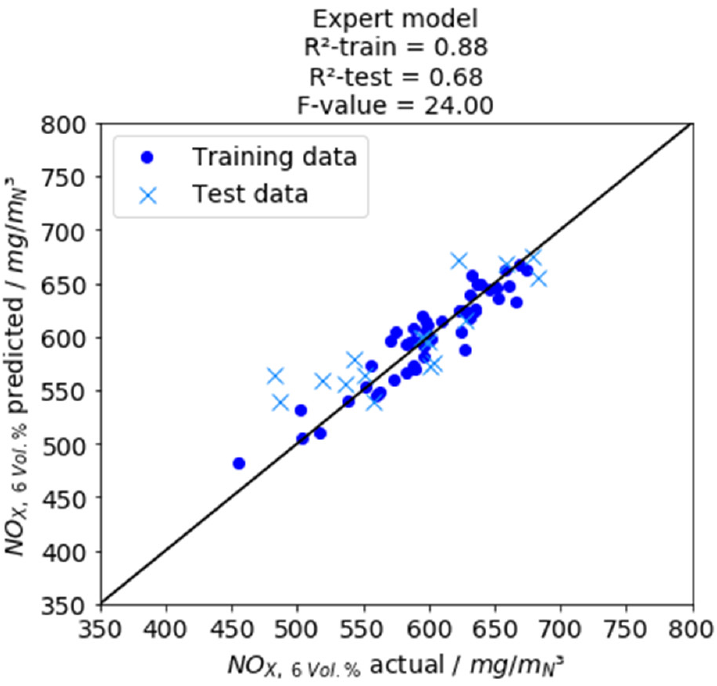
Figure 8. Results of the Expert model.